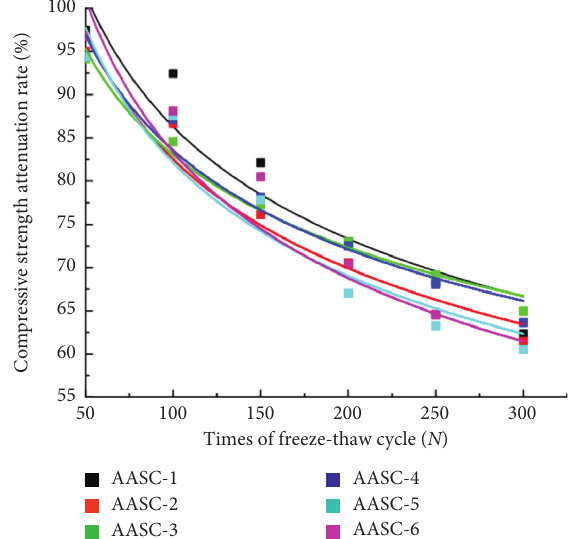
Figure 11: Compressive strength attenuation power function model.